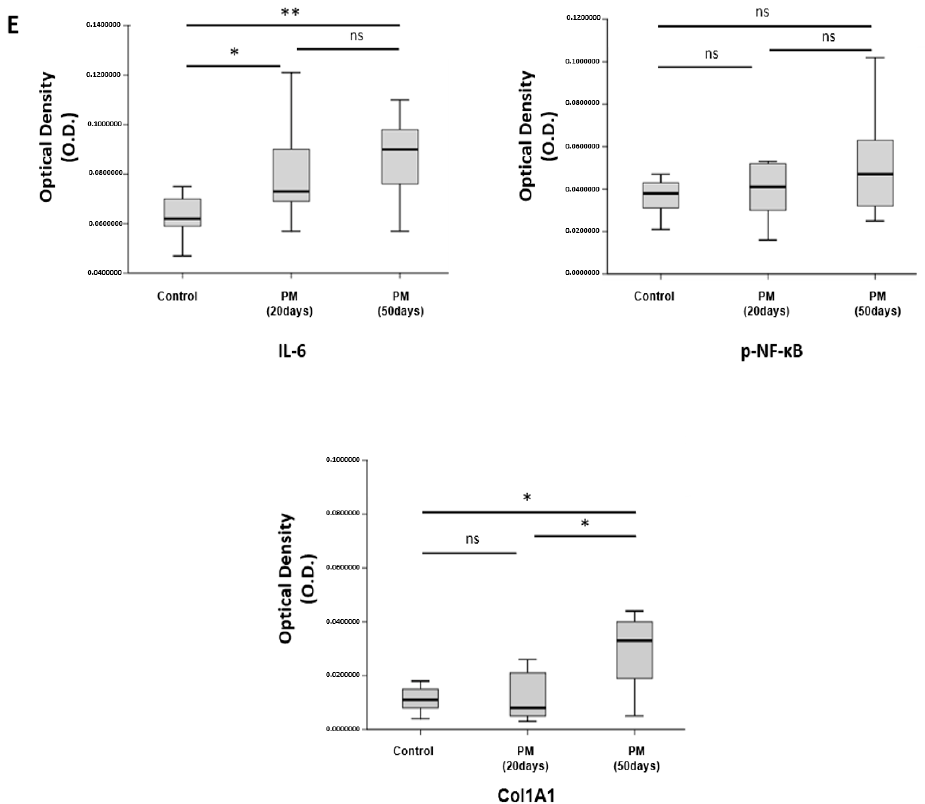
Figure 6. PM induces VF mucosal inflammation and modulates ECM in vivo. ( A ) Study protocol of the experimental group. In the experimental group, 1 mL of PM diluted in 1 mg / mL distilled water was administered through the oral cavity a total of five times every per 3 days. ( B ) Gross morphology of VF excised from sacrificed animals. ( C ) Histological analysis of VF in the control group 20 and 50 days after PM treatment. H&E staining showed that the thickness of the lamina propria was increased on day 20. VF in the PM-treated group was characterized by an irregularly arranged lamina propria on day 50 (upper-panel). In Masson’s trichrome staining, collagen was dyed dark blue. Collagen deposition was increased in the experimental group compared to the control group (mid-panel). Alcian blue stains hyaluronic acid blue. The amount of hyaluronic acid decreased slightly in the PM-treated group (bottom-panel). ( D ) Immunohistochemical analysis of VF after normal saline and PM treatment. High expression of IL-6 and collagen type I in the lamina propria was observed in the experimental group. The expression of p-NF- κ B was also increased in the epithelium after the PM treatment. ( E ) Quantitative analysis results for immunohistochemical analysis. * p < 0.05, ** p < 0.01, ns; non-specific.